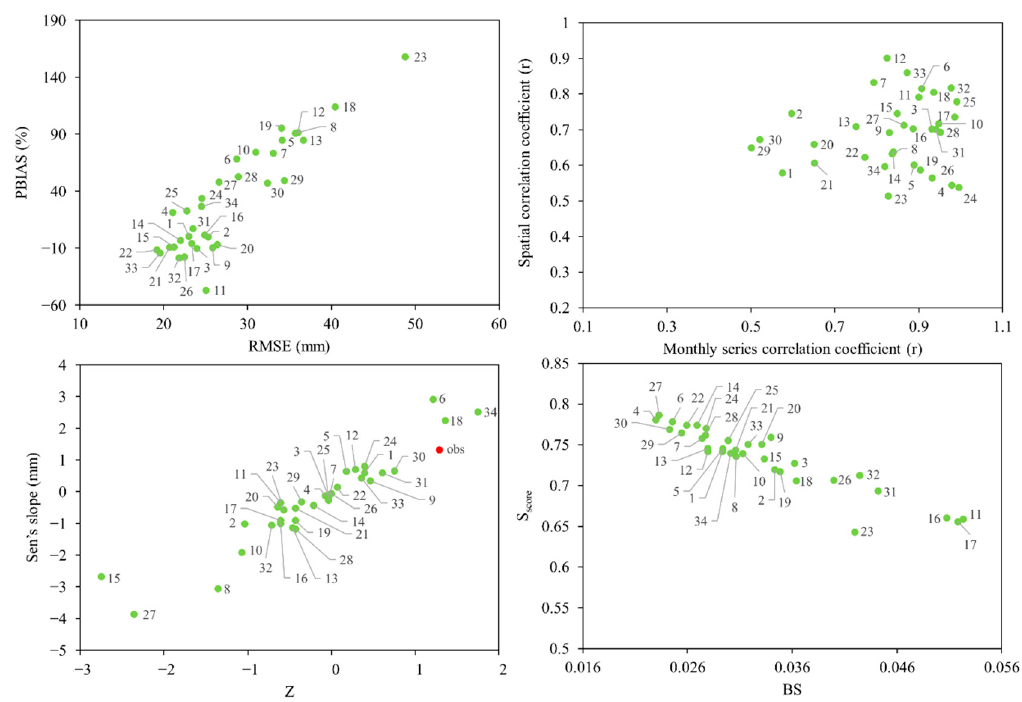
Figure 5. Scatter plots of statistics of assessment criteria for the dry season over the LMB.